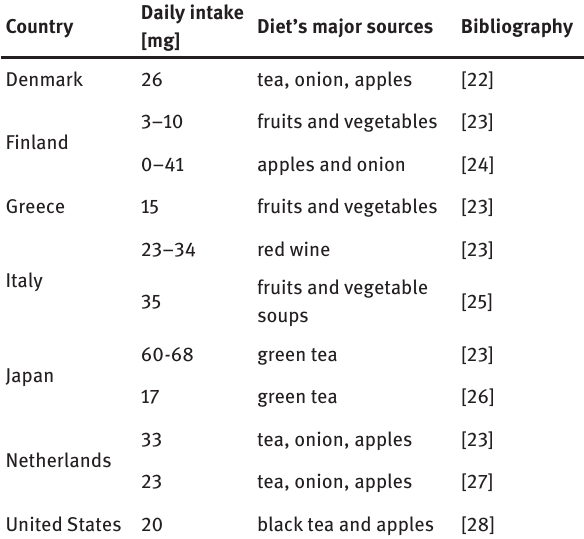
Table 5: Daily intake and major sources of food flavonoids in different countries.